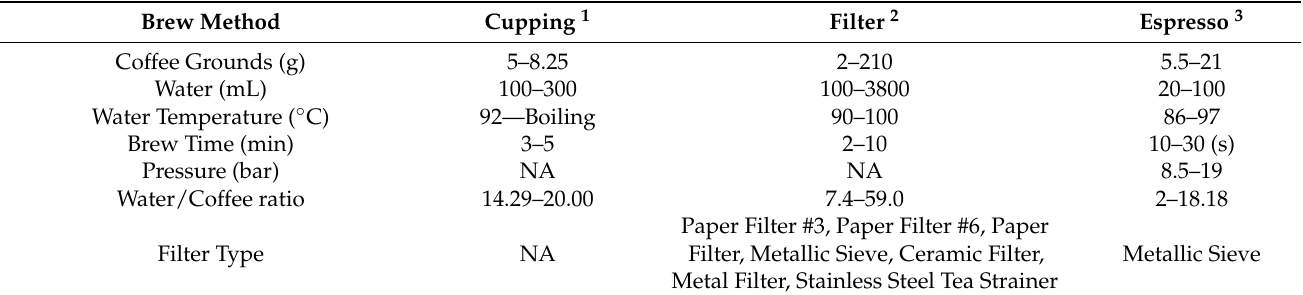
Table 1. A summary of the brew parameters presented in the literature for cupping, filter, and espresso methods.